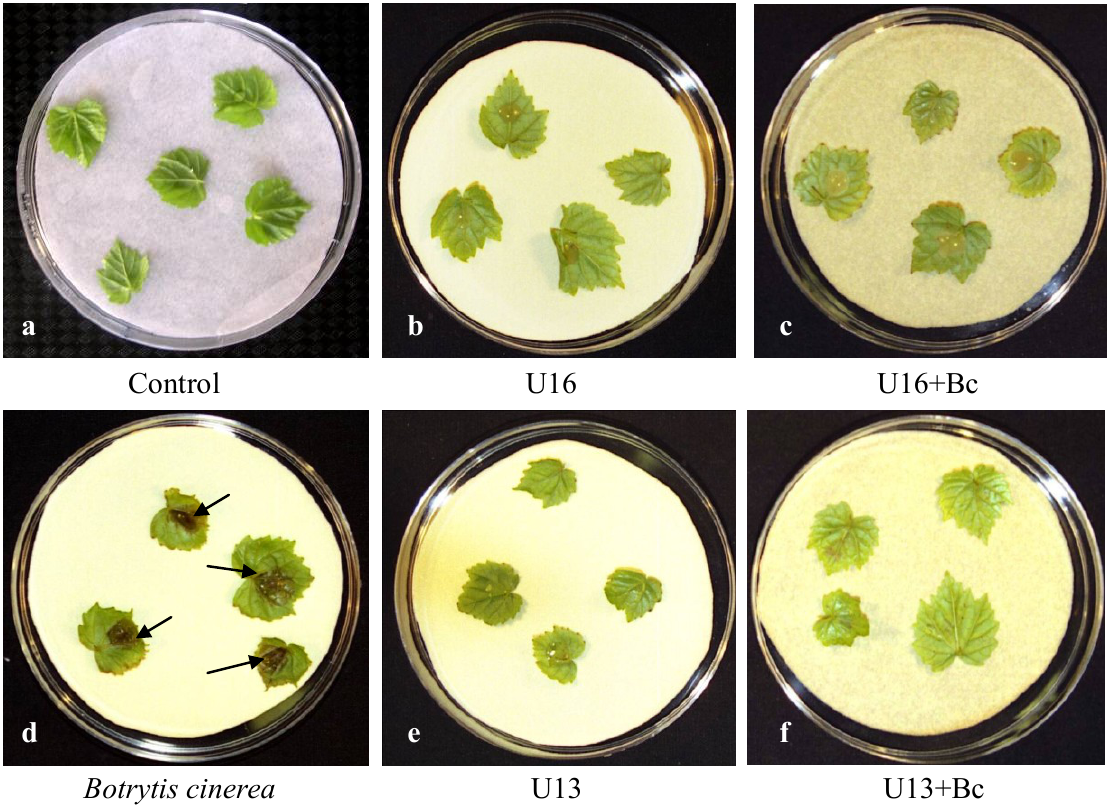
Figure 3. Phytopathogenicity tests three days post inoculation. Leaves of Vitis vinifera L. responding to challenge with gray mold by developing large lesions clearly delimited from the surrounding healthy tissues and which are typical symptoms of gray mold ( d ); Leaves of grapevine inoculated with U. atrum (U13 or U16 isolates) were healthy ( b , e ); No gray mold symptoms were observed when U. atrum -inoculated leaves were challenged with B. cinerea ( c , f ); a : control.